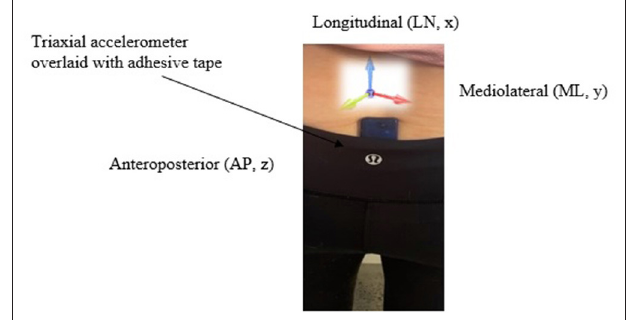
FIGURE 1 | Depiction of orthogonal axes orientation and sensor used in study.